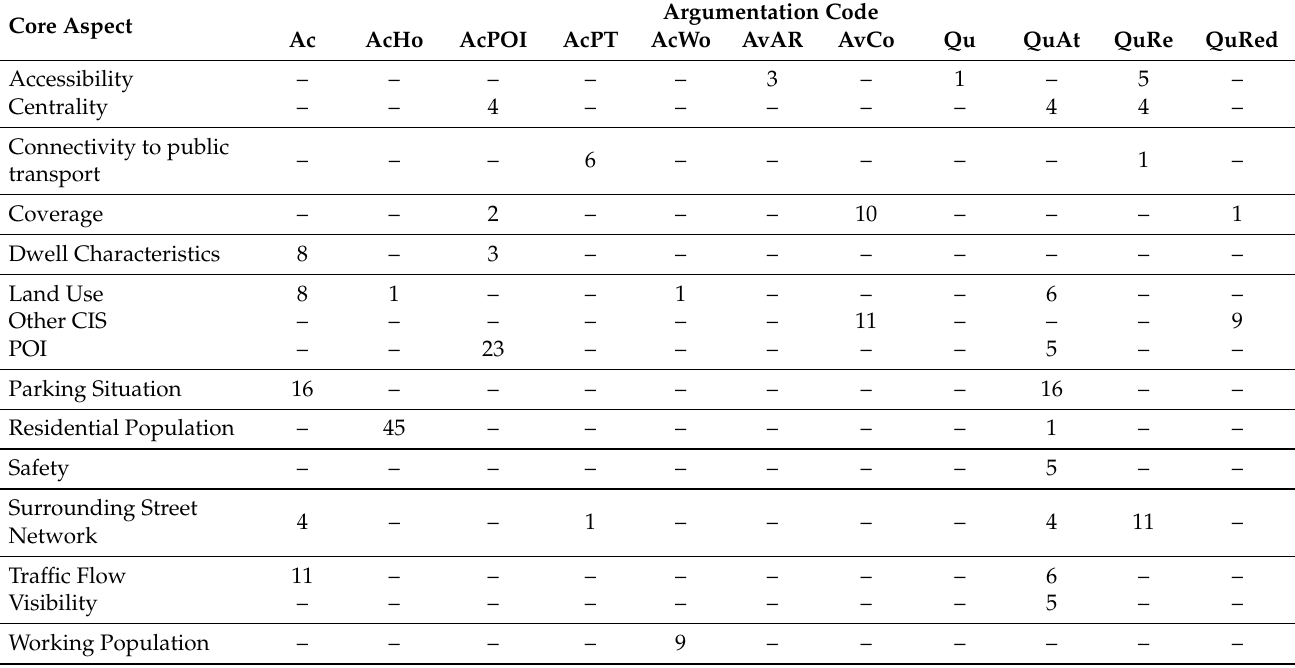
Table 4. Argumentation code frequency per core